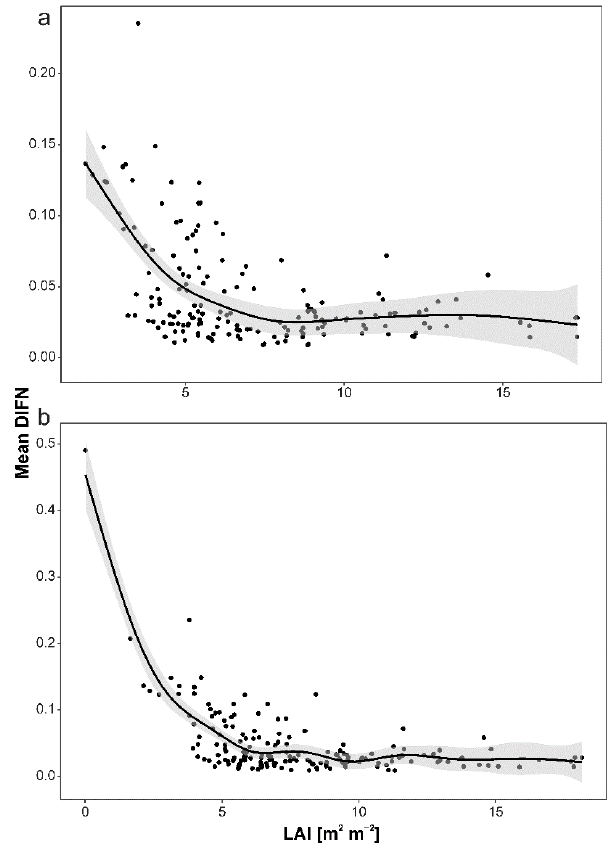
Figure 2. Relationship between diffuse non-interceptance (DIFN) and leaf area index (LAI) estimated using generalized additive models (GAMs; for parameters see Table 1) for trees and shrubs with diameter at breast height (DBH) > 5 cm ( a ) and all trees and shrubs recorded ( b ).